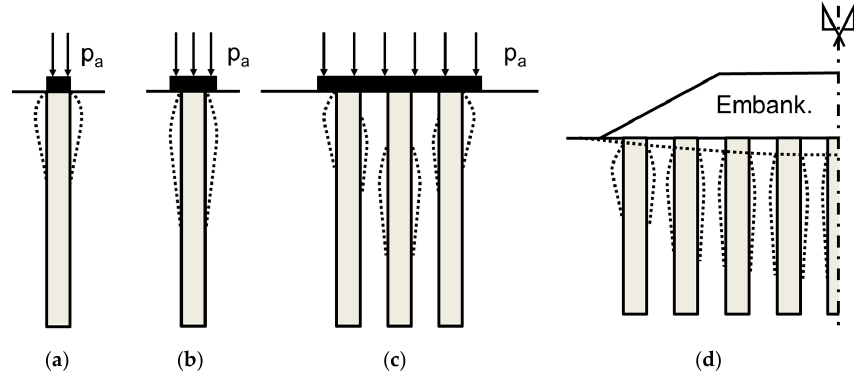
Figure 14. Column deformation for different configurations: ( a ) Isolated column with (cid:1853) (cid:3045) = 100%; ( b ) Isolated column with (cid:1853) (cid:3045) < 100%; ( c ) Groups of columns beneath footing; ( d ) Column treatment beneath an embankment.